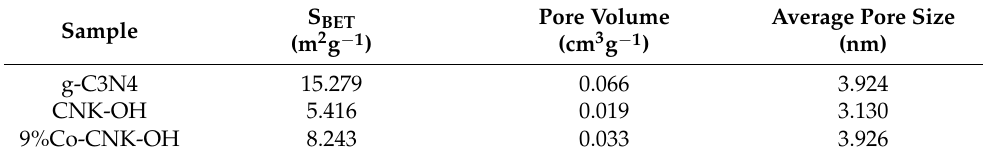
Table 1. Specific surface areas and pore-size parameters of g-C 3 N 4 , CNK-OH and 9%Co-CNK-OH.